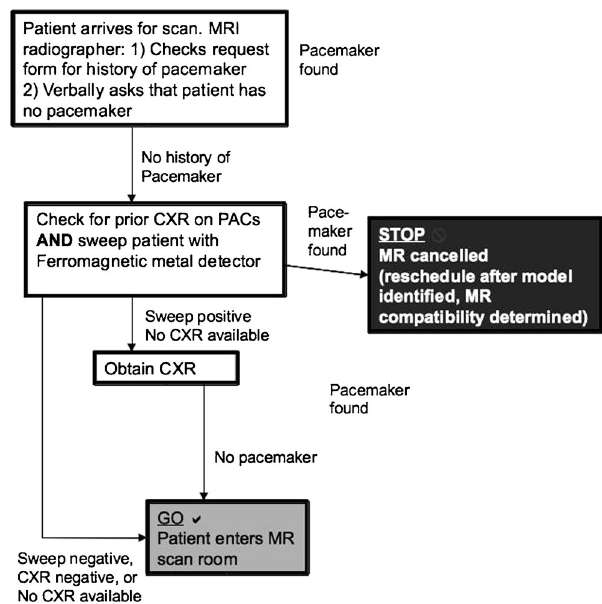
Fig. 17 Algorithm for the prevention of inadvertent scanning of patients with CIEDs (Both MR-conditional and non-MR